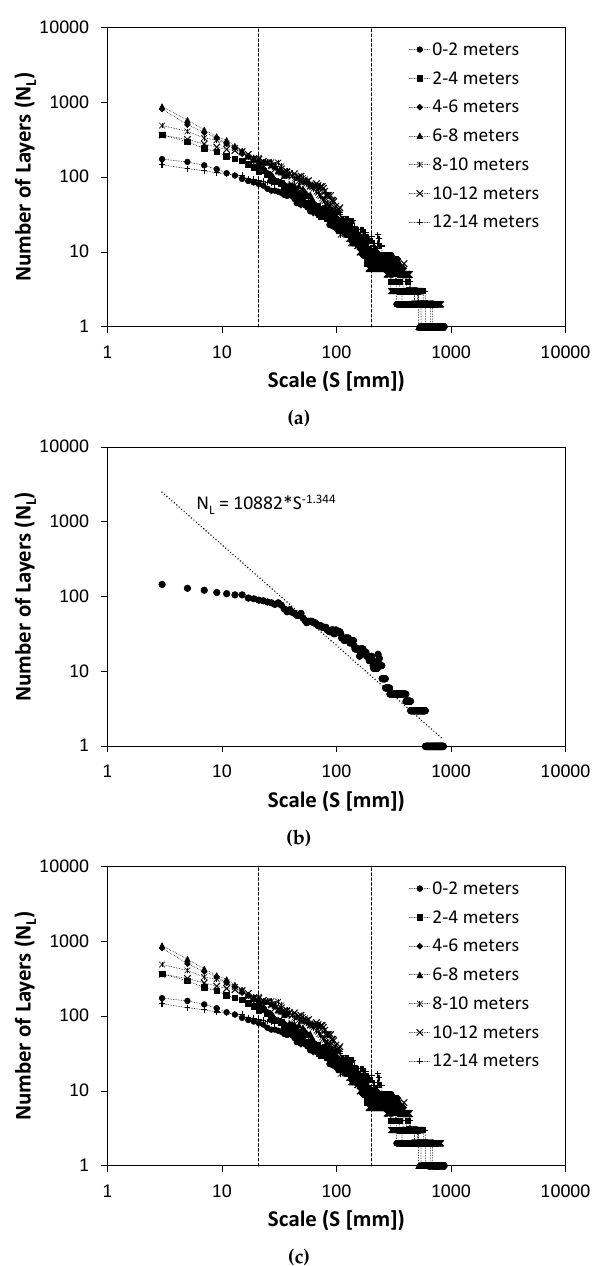
Figure 7. Examples of pseudo-spectra of the layering structure, all for the profile recorded at 12:28 on 16 June 2008 in Esthwaite Water. ( a ) depth bin from 4 to 6 m; ( b ) depth bin from 12 to 14 m; ( c ) all 2 m-depth bins together.